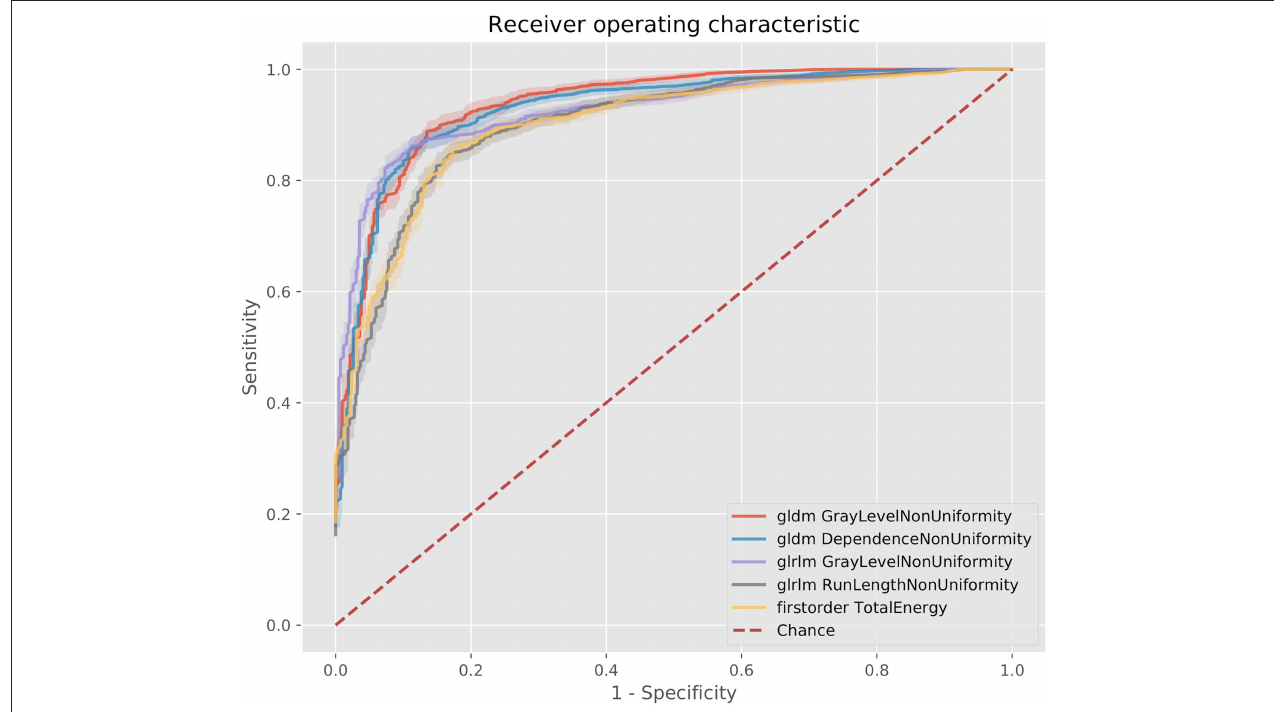
FIGURE 4 | ROC curves for the best 5 AUC values on the 80 kV images. GLDM,Gray level dependence matrix; GLRLM, gray level run length matrix.